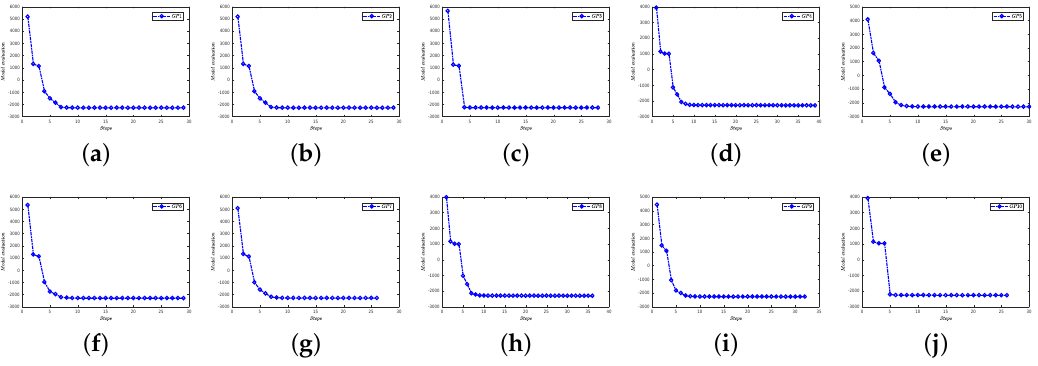
Figure 9. Evaluation of m GPs ( m = 10). According to the distributed framework, the ten GPs share the same hyper-parameters. ( a ) GP1; ( b ) GP2; ( c ) GP3; ( d ) GP4; ( e ) GP5; ( f ) GP6; ( g ) GP7; ( h ) GP8; ( i ) GP9; ( j ) GP10.